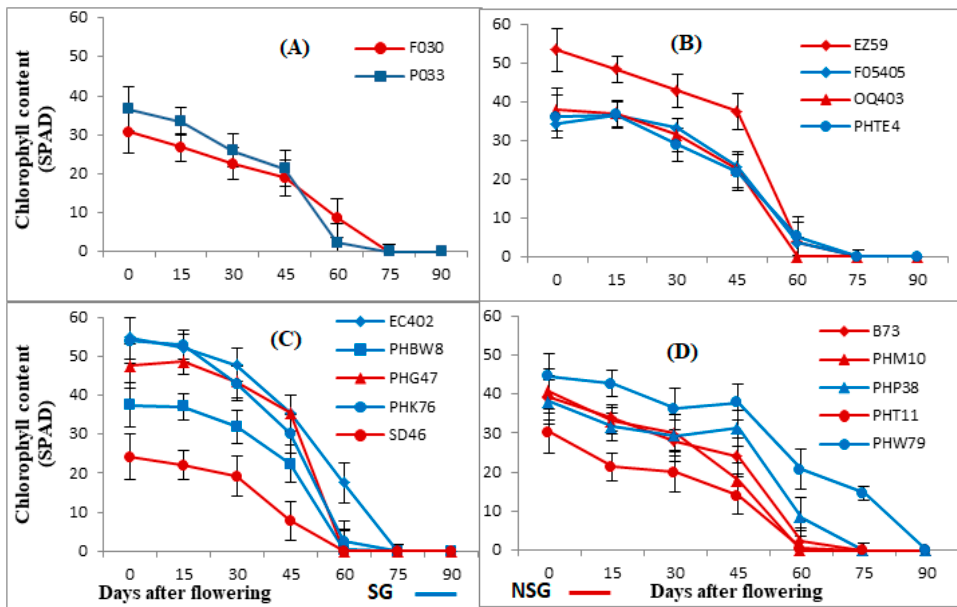
Figure 2. Chlorophyll content of 16 maize inbred lines of four flowering groups from flowering time, evaluated in 2017 in two locations in Galicia. ( A , B , C , D ) present each flowering group: very early, early, medium, and late flowering, respectively; SG: stay-green genotype. NSG: non-stay-green. Means ± std error are presented.